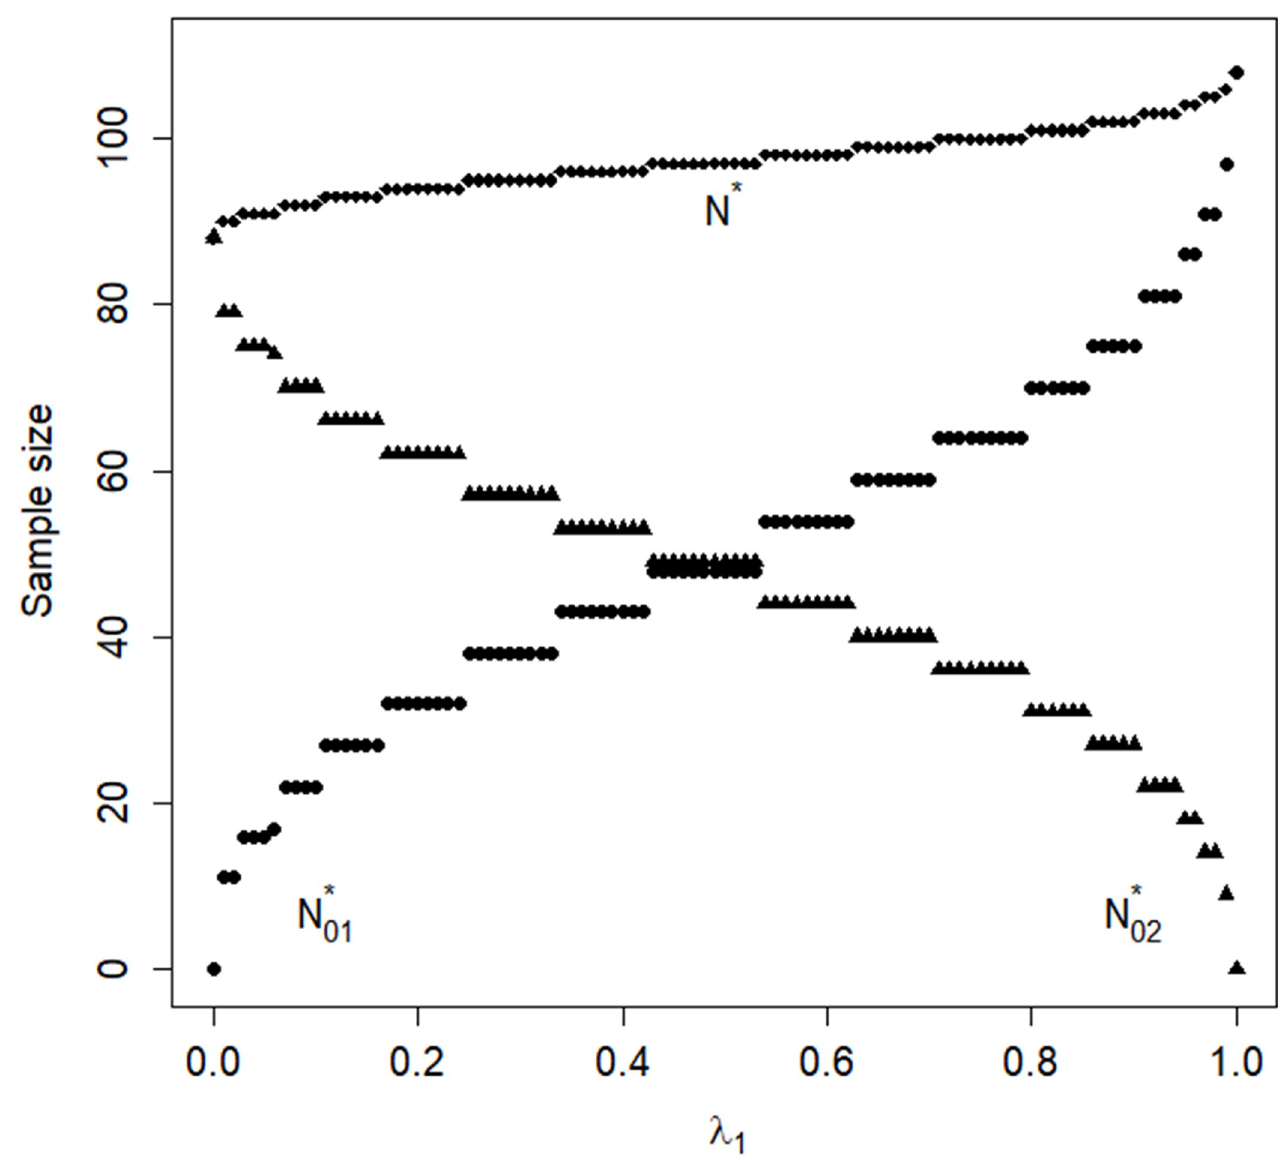
Fig 1. Optimal sample sizes as a function of the parameter λ 1